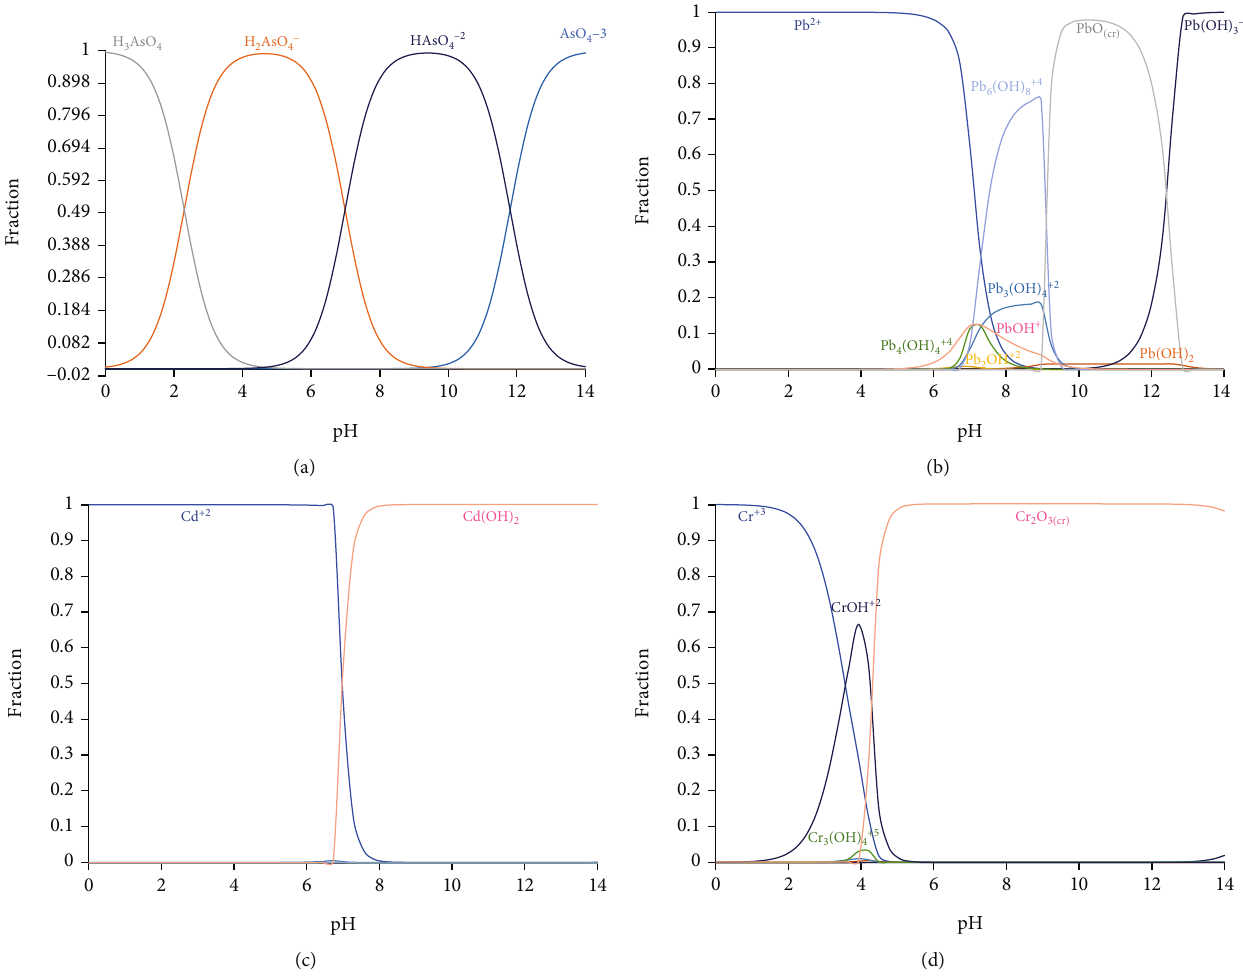
Figure 7: (a) Arsenic, (b) lead, (c) cadmium, and (d) chromium speciation as a function of solution pH in aqueous